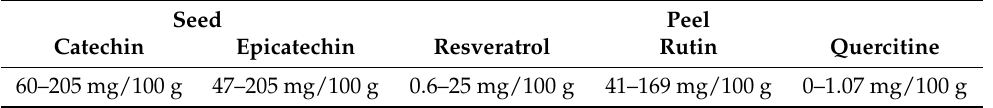
Table A1. Amounts of the most important active substances in grape marc (in seed and skin).